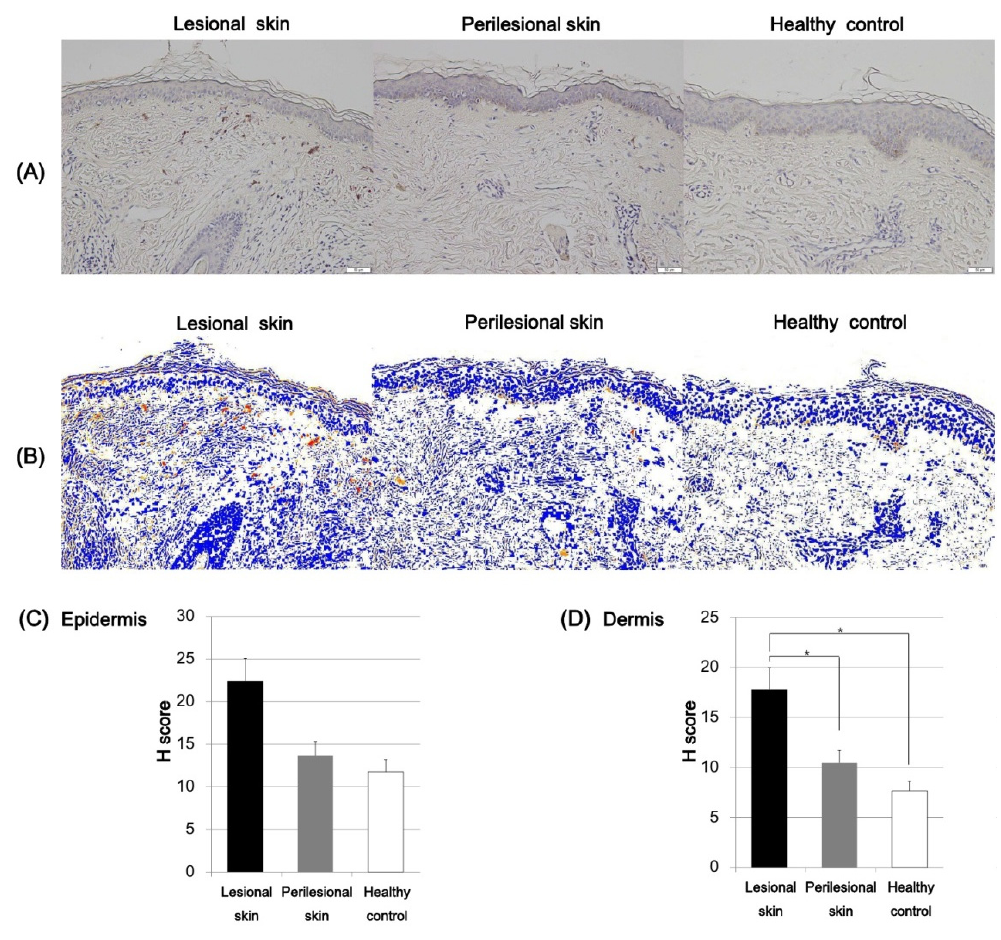
Figure 4. Expression profiles of stem cell factor (SCF) in the lesional and perilesional skin of Riehl’s melanosis and healthy controls. ( A ) The expression of SCF was increased in the lesional dermis of Riehl’s melanosis (original magnification, 200 × ). Scale bar, 50 µ m. ( B ) Densitoquant TM quantitatively measured the intensity of SCF expression in the lesional skin and perilesional skin of Riehl’s melanosis and healthy controls as follows: red, strong positive; orange, moderately positive; yellow, weakly positive; white and blue, negative. ( C ) The mean H score for SCF expression intensity in the epidermis was quantitatively evaluated in the lesional and normal-appearing perilesional skin of Riehl’s melanosis and healthy controls. ( D ) The mean H score for SCF expression intensity in the dermis was quantitatively evaluated in the lesional and normal-appearing perilesional skin of Riehl’s melanosis and healthy controls. Abbreviation: SCF, stem cell factor. * indicates a p -value of less than 0.05.